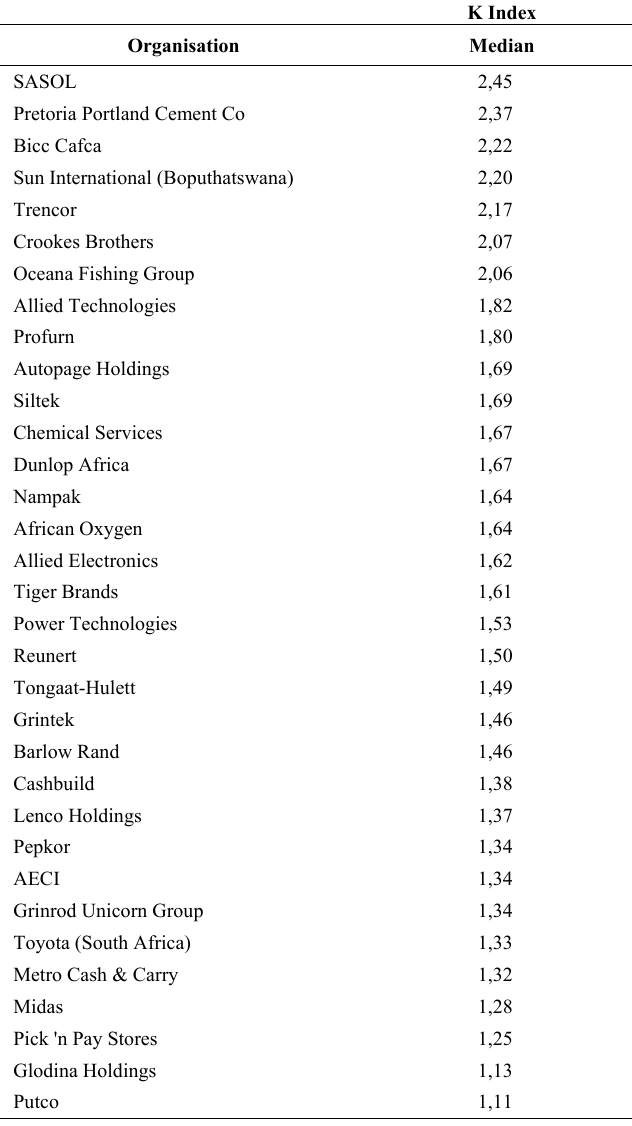
Figure 3 indicates how organisations with similar overall business control levels are grouped together in zones, but at the same time also shows how they differ in terms of their degree of vertical integration. A comparison of the top two performers in terms of the K index reveals that SASOL